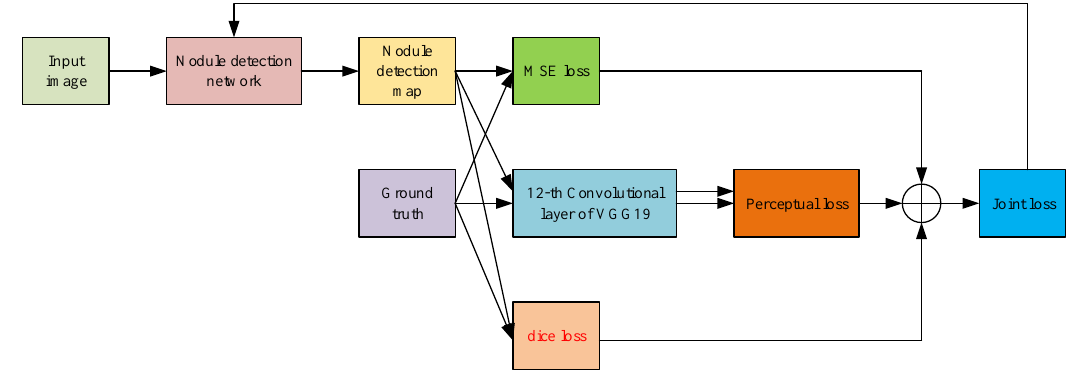
Figure 13. The flow of calculating the joint loss for optimizing the parameters of the nodule detection